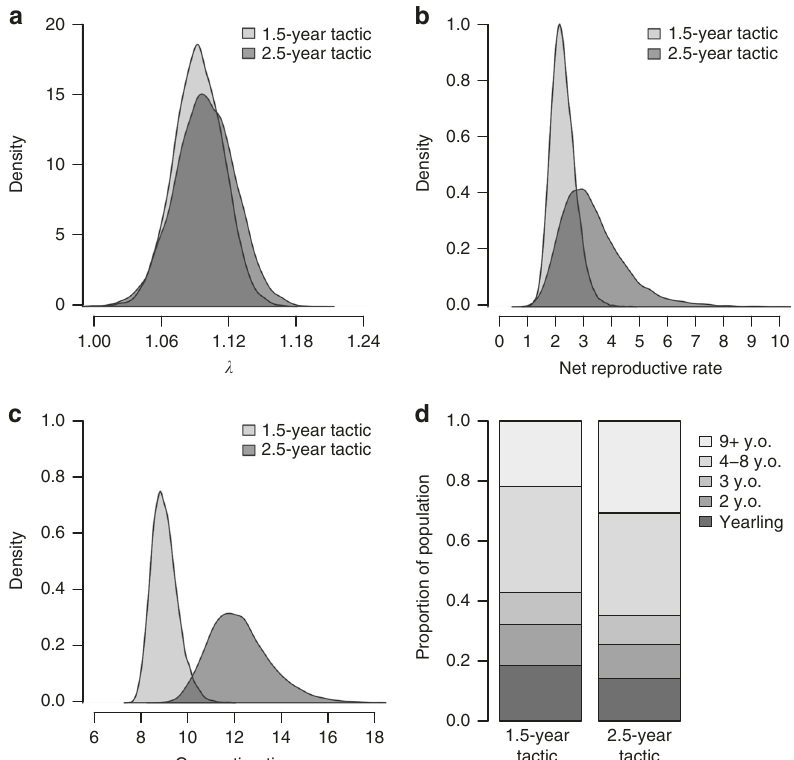
Fig. 4 Contrasted demographic parameters between brown bear maternal care tactics. a Asymptotic population growth rates, λ , b net reproductive rates, R T , and d stable age structures were extracted from tactic-based population matrices using bootstrapped predictions of age class- 0 , c generation times, speci fi c survival probabilities and recruitment (10,000 predictions per demographic parameter per age class, yielding 10,000 different